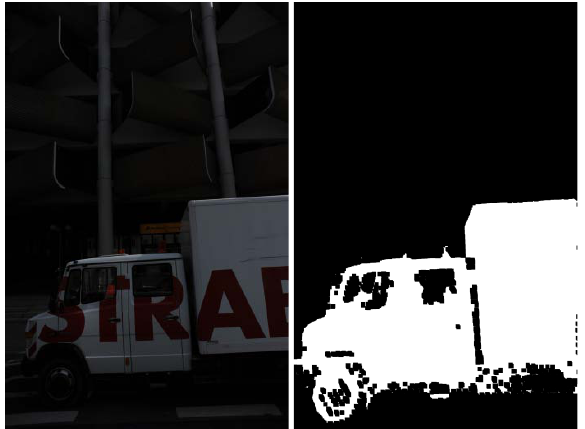
Figure 5. Car occluding a building façade (left) and corresponding occlusion mask